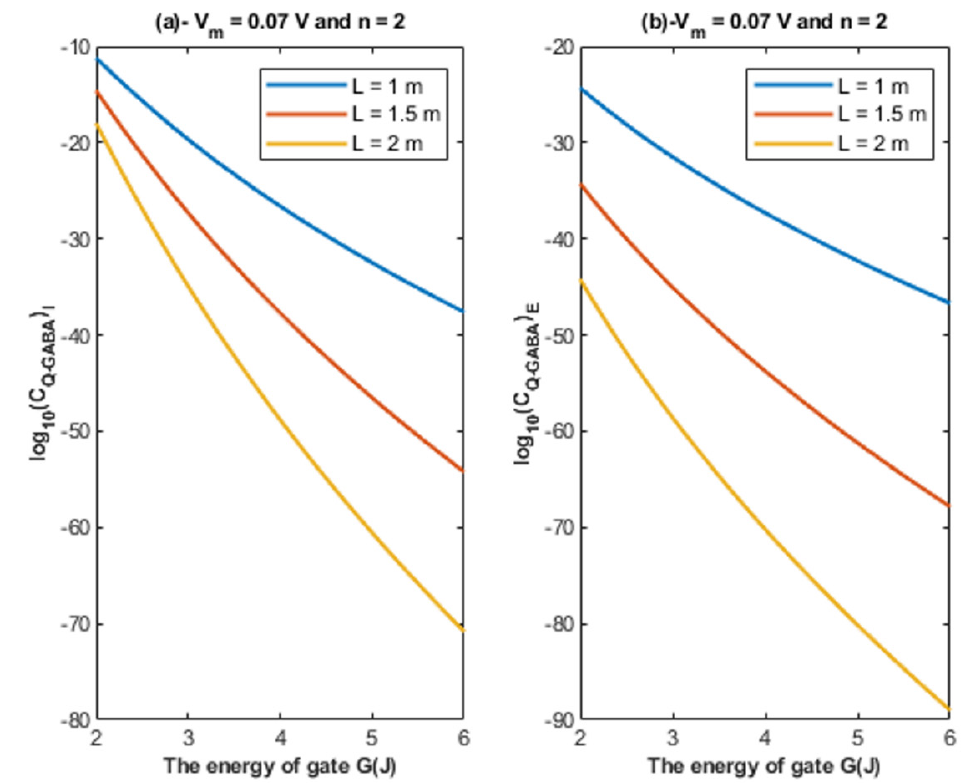
Figure 7. ( a , b ): The figure represents the relationship between the energy of the gate G and the common logarithm of the quantum unitary conductance of the intracellular chloride ions ( C ) log Q − GABA 10 and the quantum unitary conductance of the extracellular chloride ions I ( C ) log Q − GABA 10 E , respectively. The relationships are investigated at different values of gate length and according to the setting values above each graph.